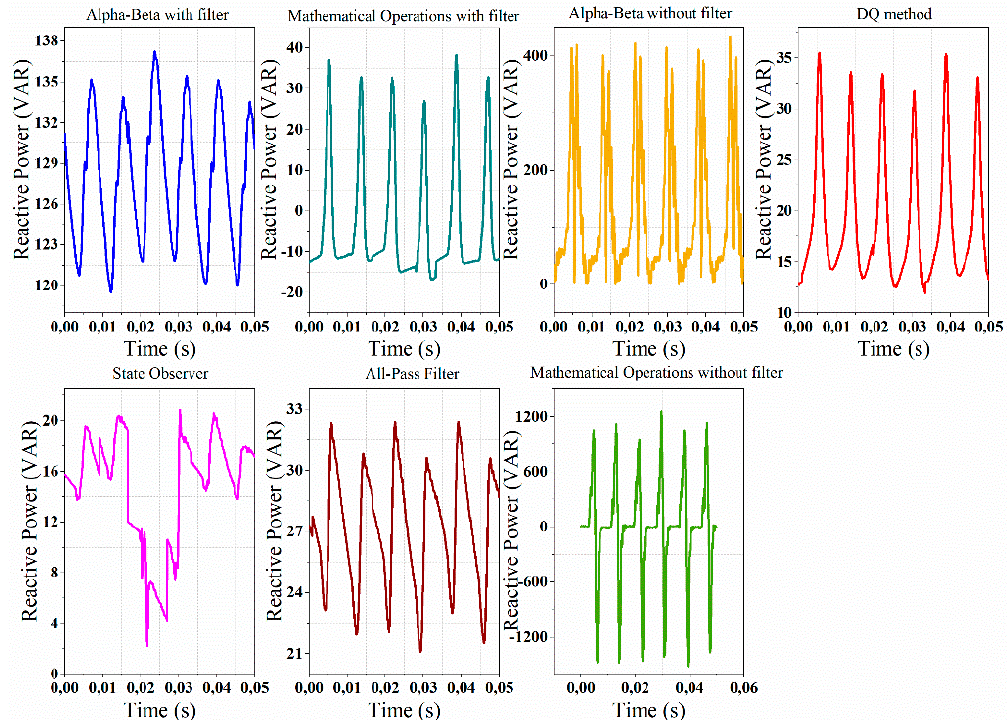
Figure 17. Reactive power calculation with all methods at the fundamental frequency—non-linear load.